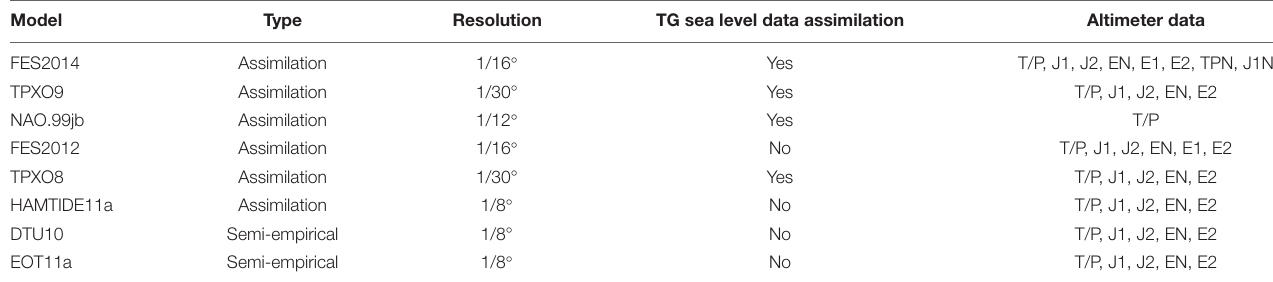
TABLE 2 | Descriptions of eight ocean tide models used in this